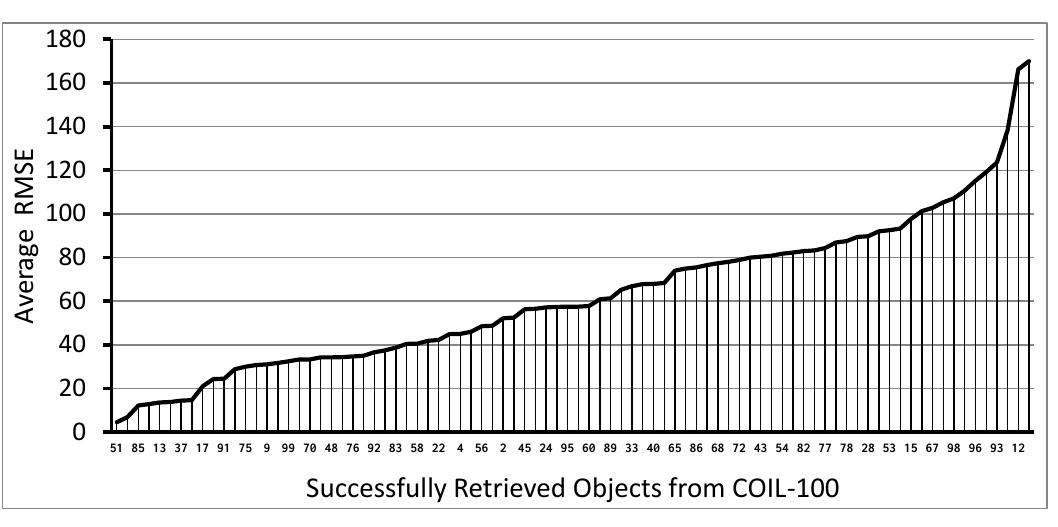
Figure 5. Average root mean square error (RMSE) of the estimated orientation angle of (motion-blurred) objects, at least once successfully retrieved from a trial of 10, with HBR ( N q = 2, ω =